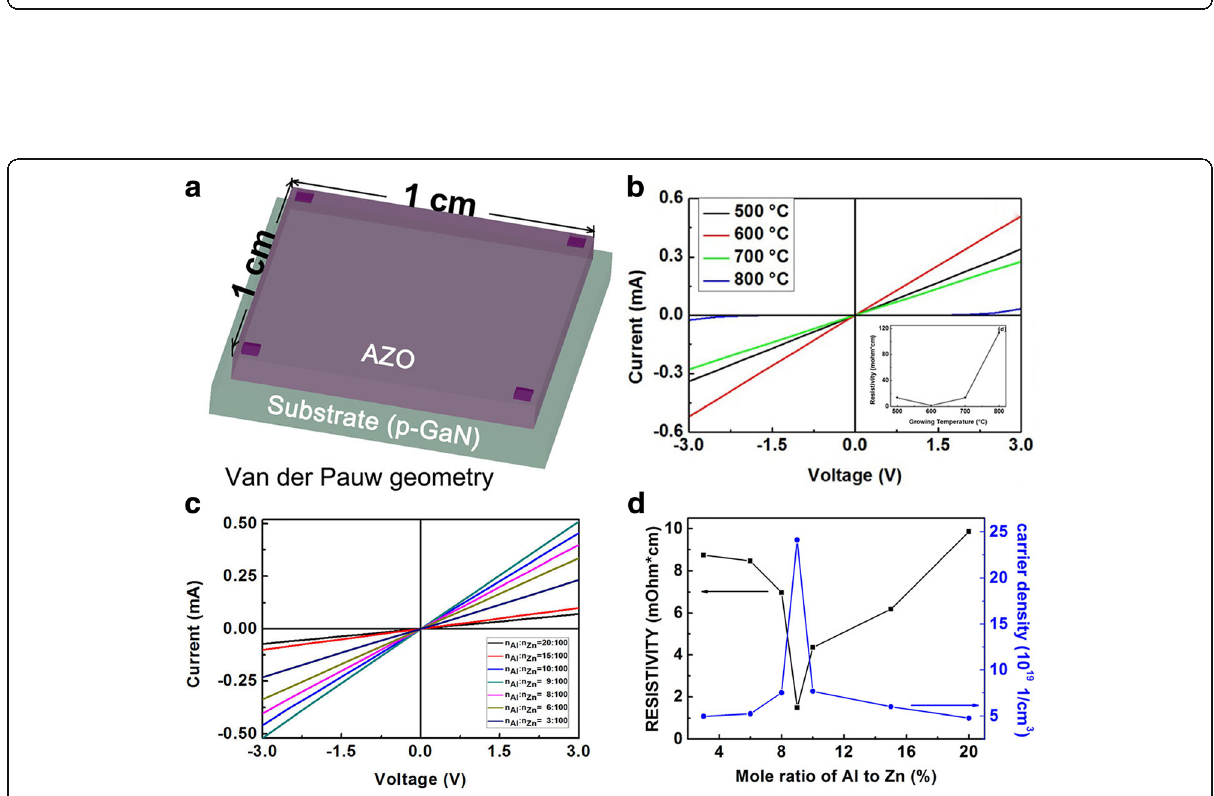
Fig. 2 a The sketch graphs demonstrating van der pauw geometry. b The resistivity of AZO films with different growth temperatures (500, 600, 700 and 800 °C). The inner graph of ( b ) shows the temperature dependence of the resistivity. c Current-voltage characteristics of different mole ratios of Al to Zn. d The resistivity and carrier density vs different mole ratios of Al to